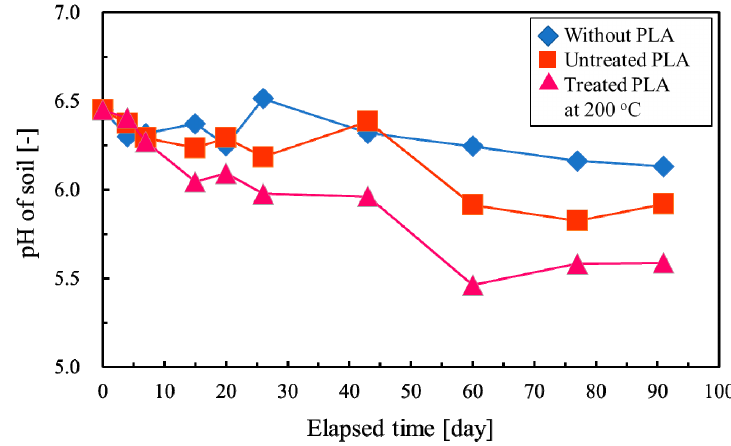
ff ect of 40 wt % polylactic acid (PLA) addition on soil pH. Figure 8. Effect of 40 wt % polylactic acid (PLA) addition on soil Figure 8. Effect of 40 wt % polylactic acid (PLA) addition on soil pH. Figure 8. E